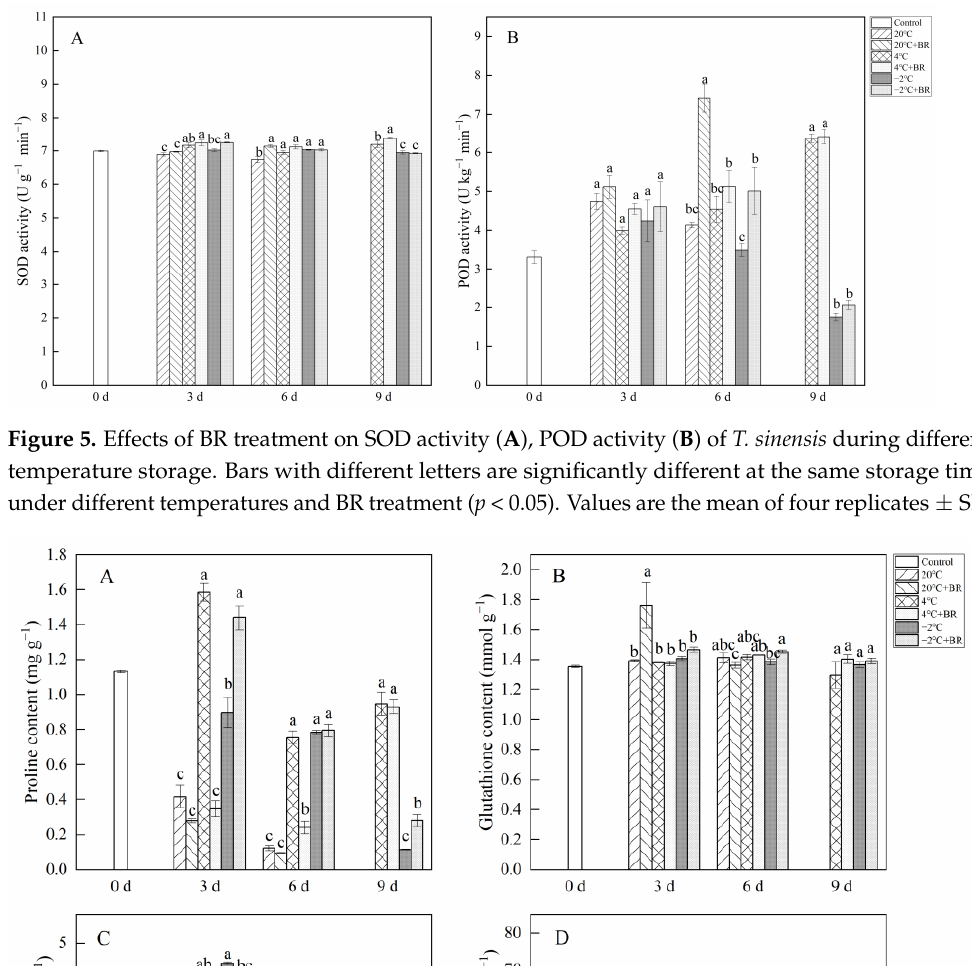
Figure 6. Effects of BR treatment on proline content ( A ), glutathione content ( B ), soluble sugar content ( C ), and soluble protein content ( D ) of T. sinensis during different temperature storage. Bars with different letters are significantly different at the same storage time under different temperatures and BR treatment ( p < 0.05). Values are the mean of four replicates ± SE.